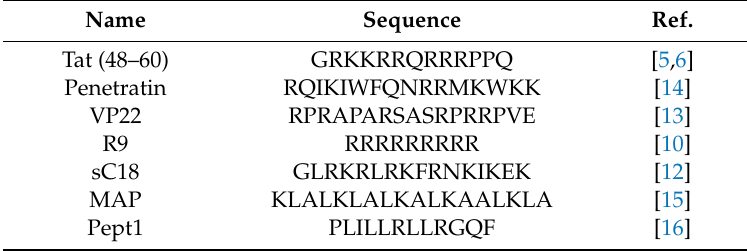
Table 1. List of some representative cell-penetrating peptides (CPPs) that have been used to create CPP-NP (nanoparticle) constructs and that are discussed within this